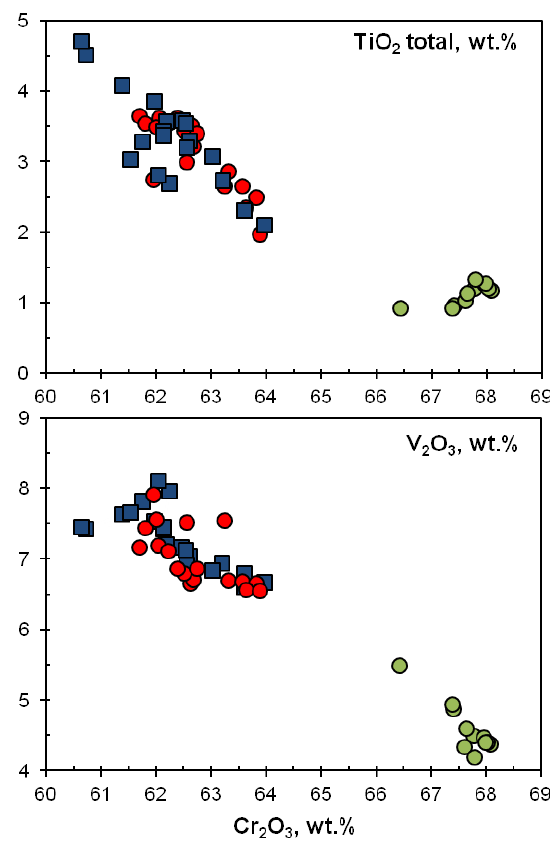
Figure 5. Chemical variations (in wt%) of TiO 2 and V 2 O 3 versus Cr 2 O 3 in ellinaite from the Hatrurim Basin. Ellinaite-1 grain: blue squares – WDS data; red circles – EDS data. Green circles – EDS data for the ellinaite-2 grain. For the database for the Hatrurim Basin ellinaite, see Tables S3 and S4.